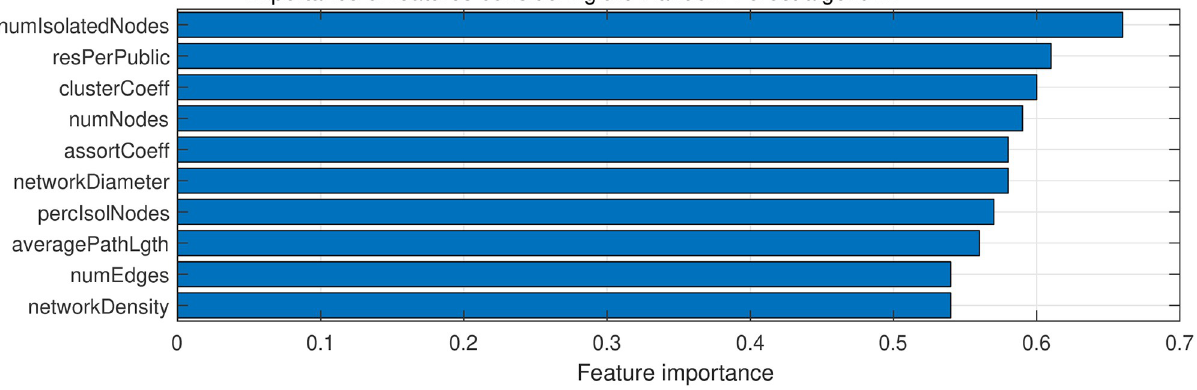
Fig 4. Importance of each feature for the classification of CAPES grade regarding the Random Forest algorithm.